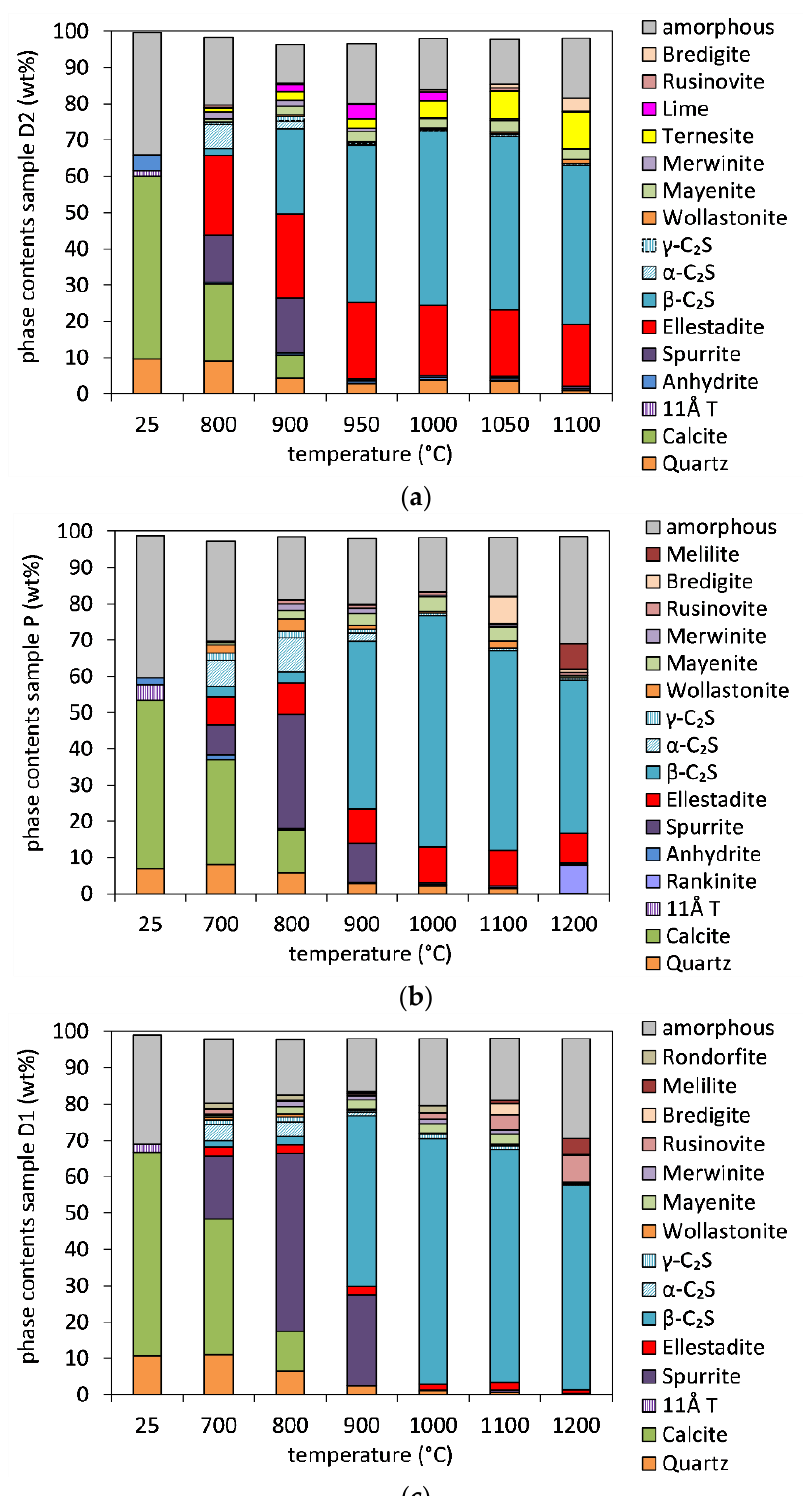
Figure 2. Variation in phase contents with heating temperature in samples with 2 wt% CaCl 2 and different sulfate amounts: ( a ) high-sulfate sample D2, ( b ) sample P with intermediate sulfate content, and ( c ) low-sulfate sample D1. Additional phase contents are ≤ 1.5 wt%: brownmillerite and melilite (D2); ≤1 wt%: CaCl 2 , rankinite (D1 + D2), albite, microcline, lime (D1 + P), ternesite (D1 + P) and rondorfite (P + D2); <0.5 wt%: Ca 2 SiO 3 Cl 2 , ye’elimite and anhydrite ( D1). The X-ray amorphous content decreases in all samples from values between 30 and 39 wt% for the raw mixtures, to values between 12 and 18 wt% at temperatures around 1000 °C. However, at higher temperatures, the amount of amorphous material increases again. At 1200 °C, samples D1 and P contain amorphous contents of 27 and 30 wt%, re- spectively. The raw material components calcite, quartz, anhydrite, and tobermorite show